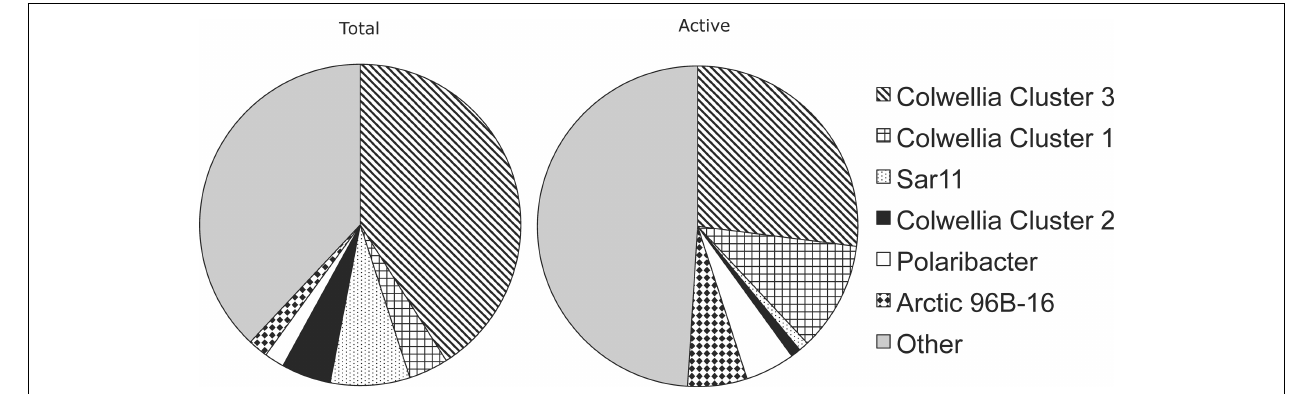
FIGURE 3 | Proportion of bacterial groups present in the total and the active (BrdU-labeled) fraction of the community. Data obtained byTRFLP represent averages across all three experiments. Colwellia cluster3, cluster1,